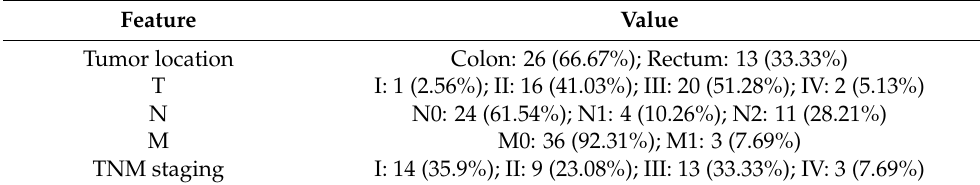
Table 1. Clinicopathological characteristics of the study group. Feature Value Tumor location Colon: 26 (66.67%); Rectum: 13 (33.33%)